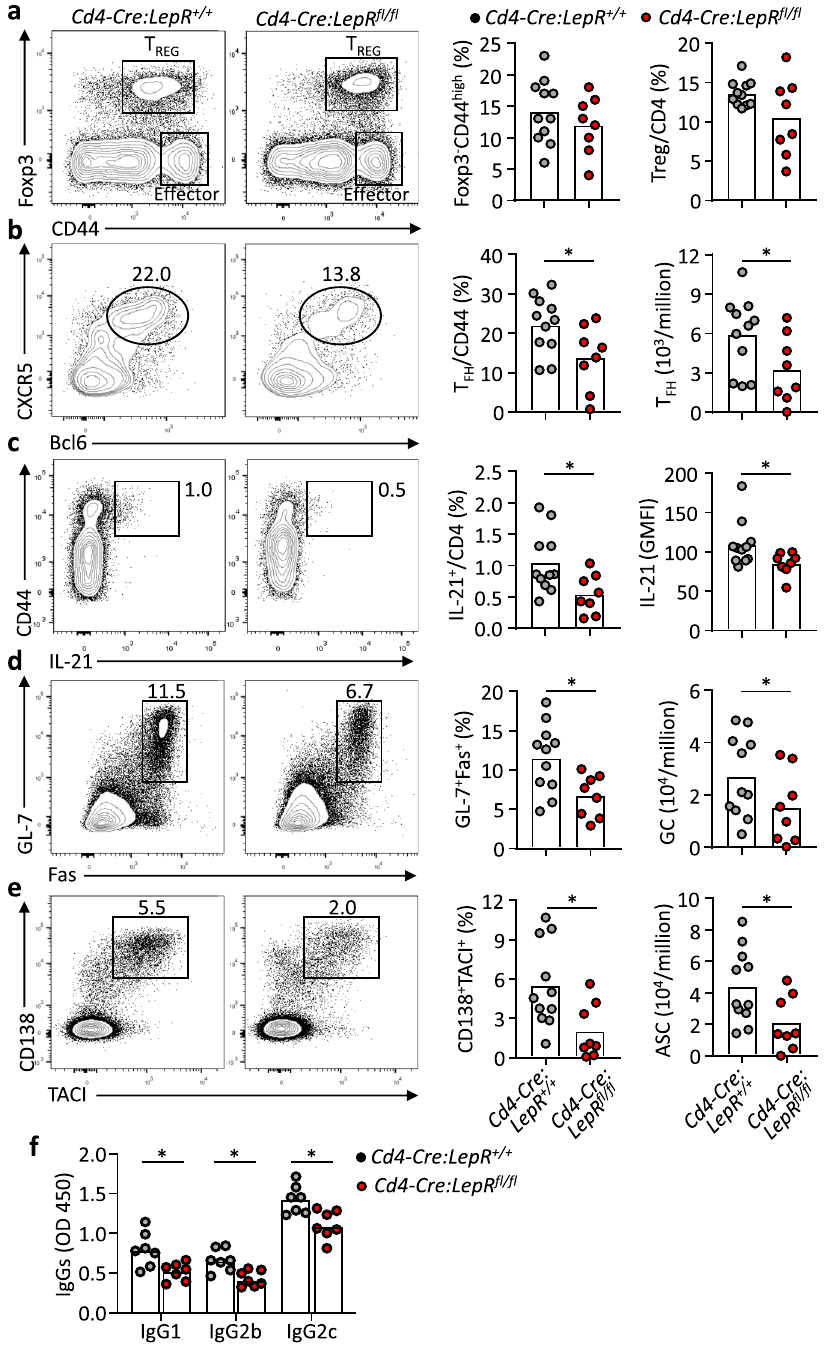
Fig. 4 Defective T FH cells responses in Cd4-Cre:LepR fl / fl mice after in fl uenza virus infection. a – e Cd4-Cre:LepR + / + mice (grey, n = 11) and Cd4-Cre: LepR fl / fl mice (red, n = 8) were infected with in fl uenza virus A/X-31 (H3N2). Mediastinal lymph nodes were analysed at day 9 post-infection. Representative FACS plots and statistics showing the CD4 + Foxp3 - CD44 high effector cells, CD4 + Foxp3 + T REG cells ( a ), CD44 + CXCR5 + Bcl6 + T FH ( b ), (* P = 0.0499, * P = 0.0347), IL-21 production ( c ), (* P = 0.0313, * P = 0.0142), B220 + GL-7 + Fas + GC B cells ( d ) (* P = 0.0151, * P = 0.0249) and B220 - CD138 + TACI + ASCs ( e ) (* P = 0.0250, * P = 0.0409) 9 days post in fl uenza viral infection. f Cd4-Cre:LepR + / + and Cd4-Cre:LepR fl / fl mice were intranasally challenged with H1N1 in fl uenza virus and virus-speci fi c IgG1, IgG2b and IgG2c in sera were measured by ELISA 9 days post-infection ( n = 7 per genotype) (IgG1: * P = 0.0183, IgG2b: * P < 0.0181, IgG2c: * P = 0.0168). Data are shown for individuals (dots) and mean (bars) values, and analysed by Mann – Whitney U-test ( a – f ). * P < 0.05, ** P < 0.01. Results are representative of two independent